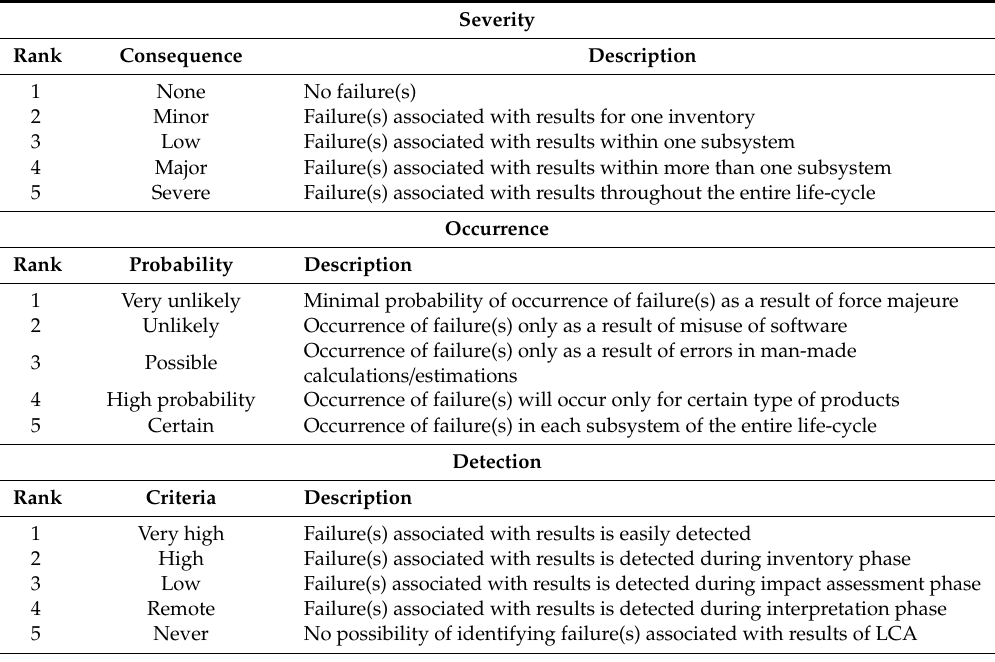
Table 1. Severity, Occurrence and Detection rating